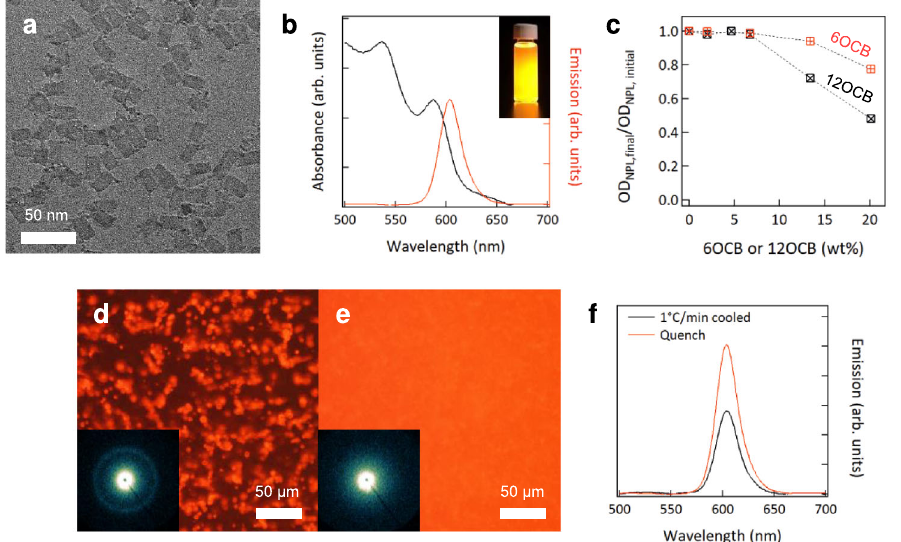
Fig. 4 Dispersion stability of CdSe/ZnS core/shell NPLs in PNBCB/6OCB. a TEM image of CdSe/ZnS NPLs. b Absorption and emission spectra of CdSe/ ZnS NPLs. Inset shows a photograph of the NPL solution emitting orange light under UV irradiation. c Stability of NPLs in chloroform as a function of the concentration of 6OCB and 12OCB. This is quanti fi ed by the decrease in OD of supernatants after gentle centrifugation of the solutions. d , e Fluorescence microscopy (FM) images of NPL/PNBCB/6OCB composite fi lms obtained ( d ) by slow cooling at 1 °C/min and ( e ) rapidly quenching from the isotropic phase to room temperature, respectively. Insets show the corresponding SAXS patterns. f Photoluminescence intensity of a slowly cooled or quenched composite fi lm, measured using a spectrometer with an integrating